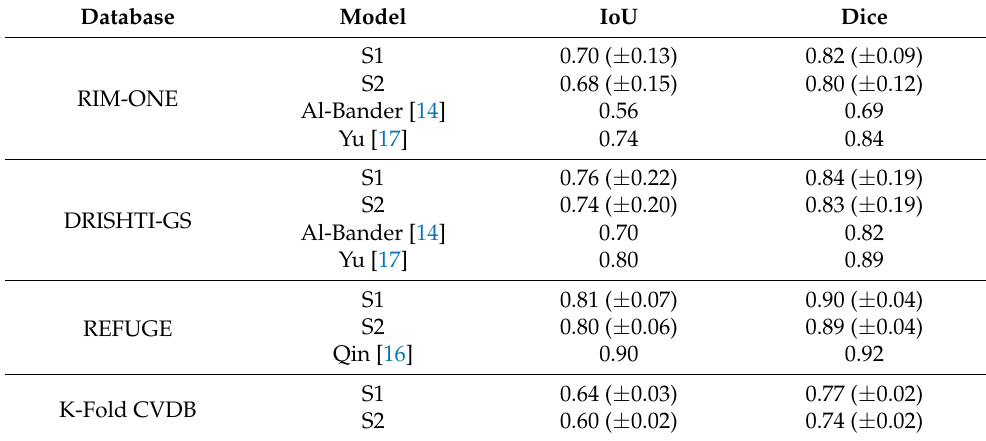
Table 6. Results for cup segmentation for each model and the K-Fold CVDB. For comparison, the results from the literature review are represented as